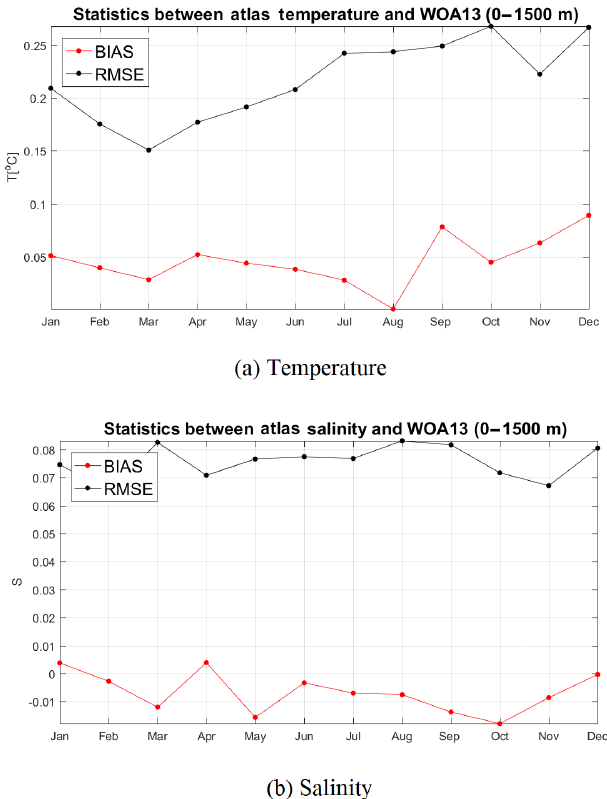
Figure 12. Basin vertical averages of BIAS and RMSE between atlas and WOA13 monthly temperature (a) , and monthly salinity (b)